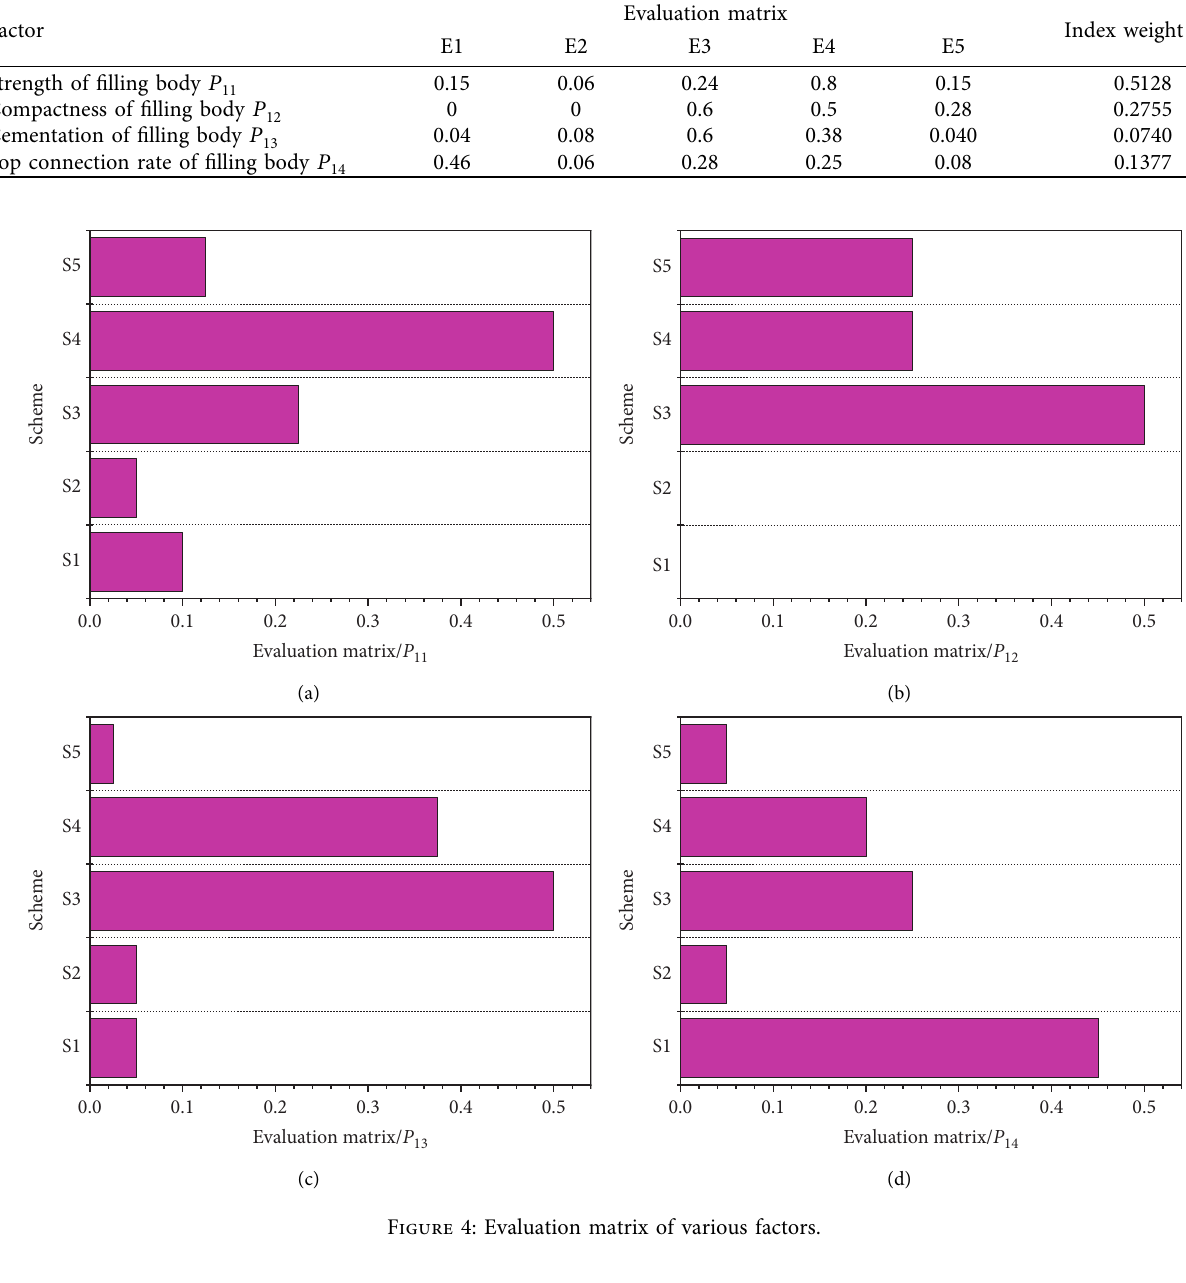
Table 4: Judgment matrix of filling stability.